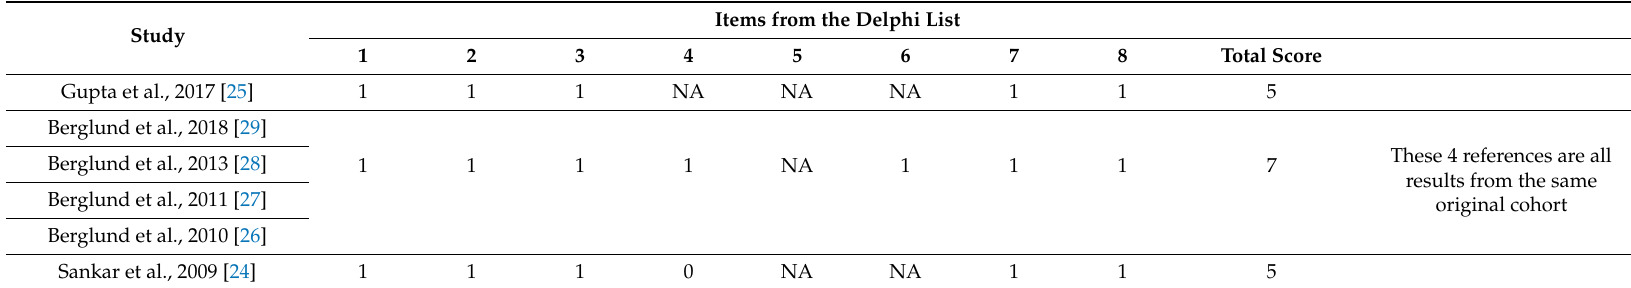
Table 1. Score breakdown on 8 items from the Delphi list for each randomized study.